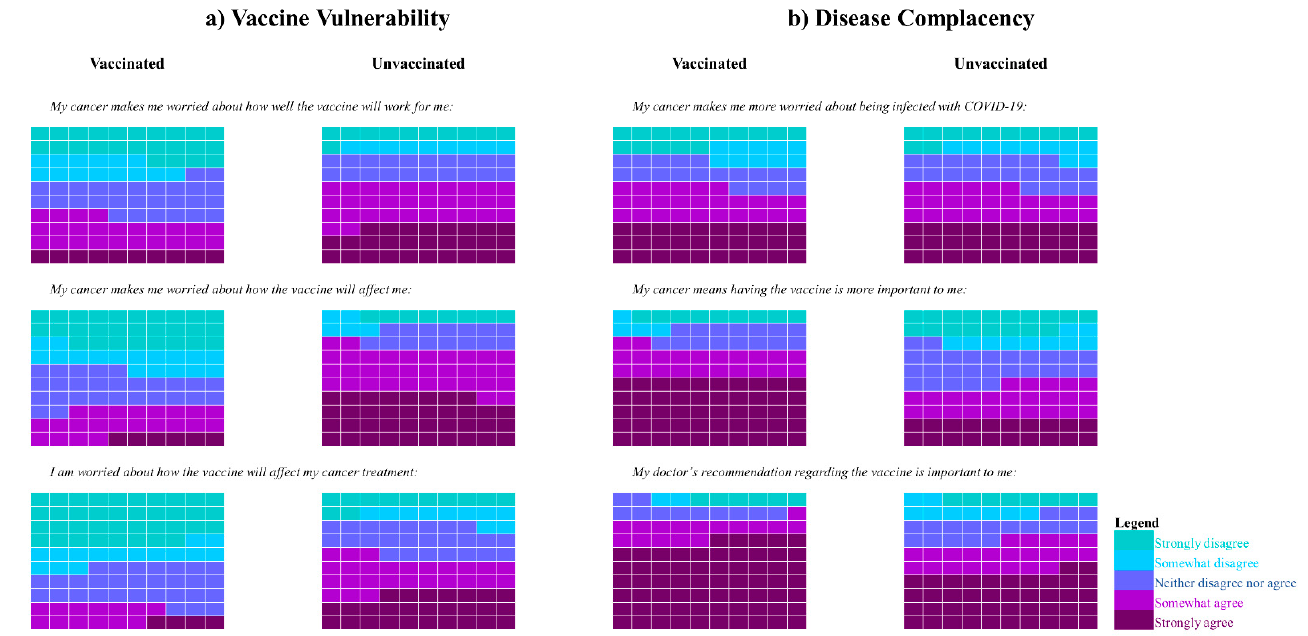
Figure 3. Response frequencies for the DIVAS-6 subscales: ( a ) Vaccine Vulnerability ( b ) Disease Complacency. Each box represents 1% of responses. Abbreviations: DIVAS-6, Disease Influenced Vaccine Acceptance Scale-6 (please see Figure S3 for clearer figure).